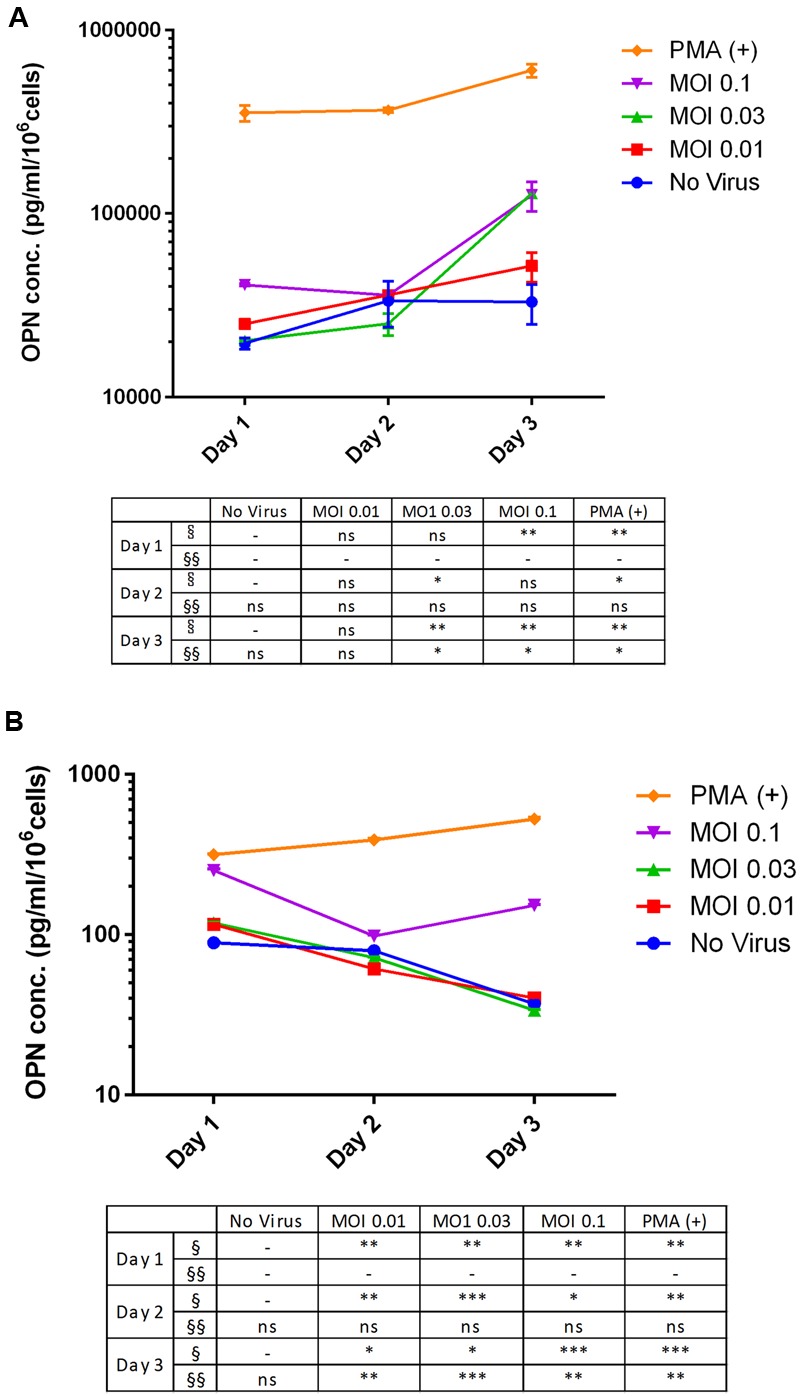
Multiplicity of infection- and time-dependent change in OPN protein expression upon DENV infection. (A) THP-1 and (B) 293T cells were infected with DENV-3 at various MOIs (range: 0.01–0.1). PMA was used as a positive control. Cells were harvested daily (1–3 days) and OPN protein levels in the supernatant were measured by ELISA. Viability was simultaneously evaluated to normalize the results. Normalized OPN levels in each sample are expressed as pg/ml/106 cells. The table summarizes statistical analysis, ∗P < 0.05, ∗∗P < 0.01, ∗∗∗P < 0.001 vs. control (uninfected cells; unpaired two-tailed t-test). Data represent mean ± SEM. § and §§ represent MOI- and time-dependent variables, respectively.